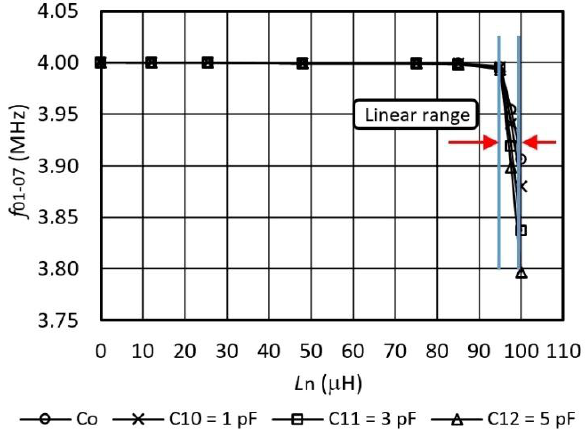
Figure 5. Inductance-frequency characteristics f 01-07 for inductance settings in steps of 0 µ H, 12 µ H, 25.4 µ H, 48 µ H, 75 µ H, 85 µ H, 95 µ H, 97.5 µ H, and 100 µ H (for different values of capacitance C 10 – C 12 in parallel to the crystal at T = 25 °C).